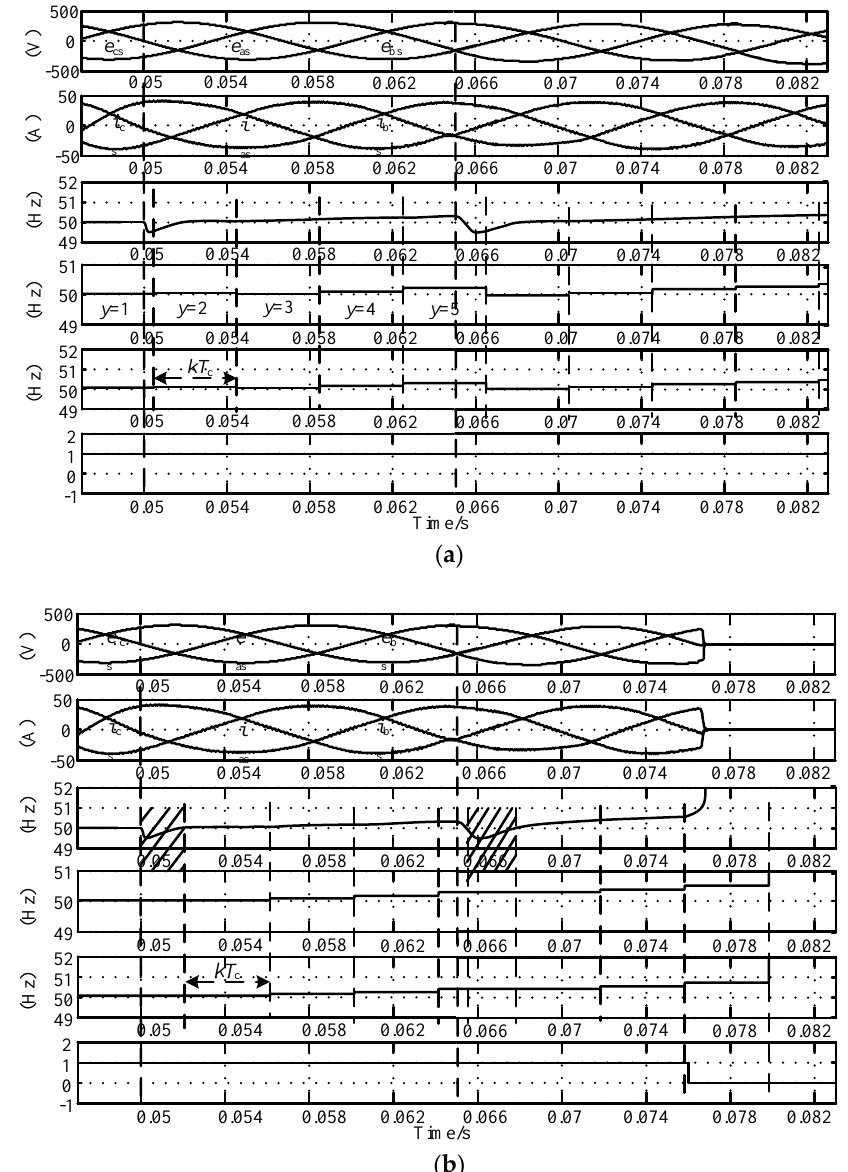
Figure 9. The simulation results with the capacitive load. ( a ) Without the NDZ estimation method. ( b ) With the NDZ estimation method.